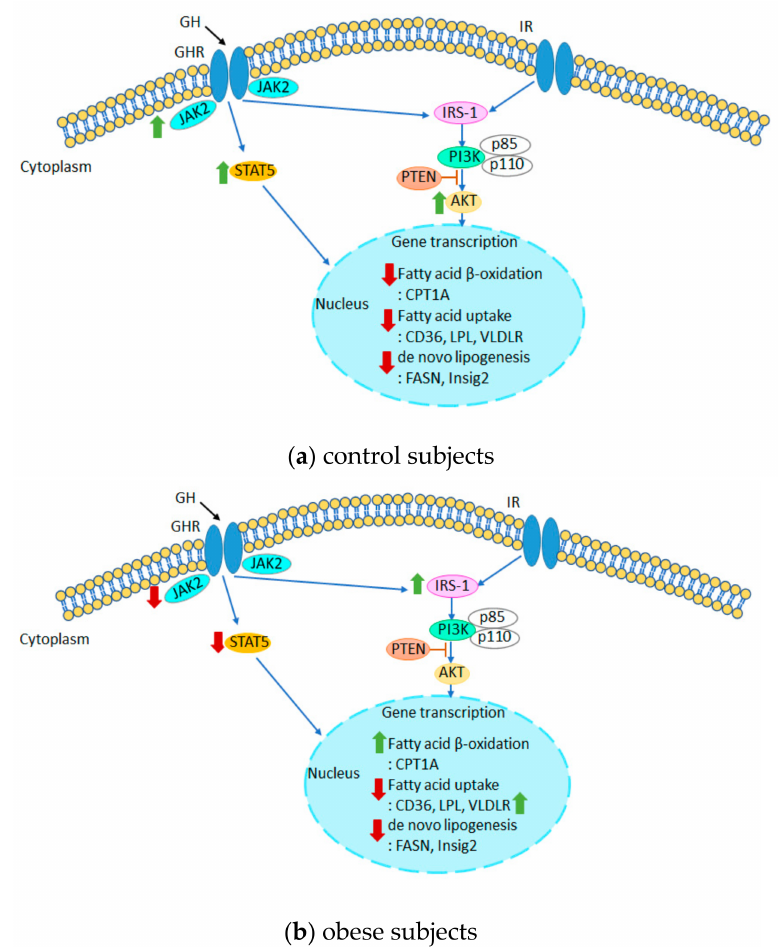
Figure 7. ( a ) The effect of short-term GH administration on the GHR and IR signaling pathway and gene transcription of lipid metabolism in hepatocytes of control rats. ( b ) The effect of short-term GH administration on the GHR and IR signaling pathway and gene transcription of lipid metabolism in hepatocytes of DIO rats. ↑ = increase; ↓ =